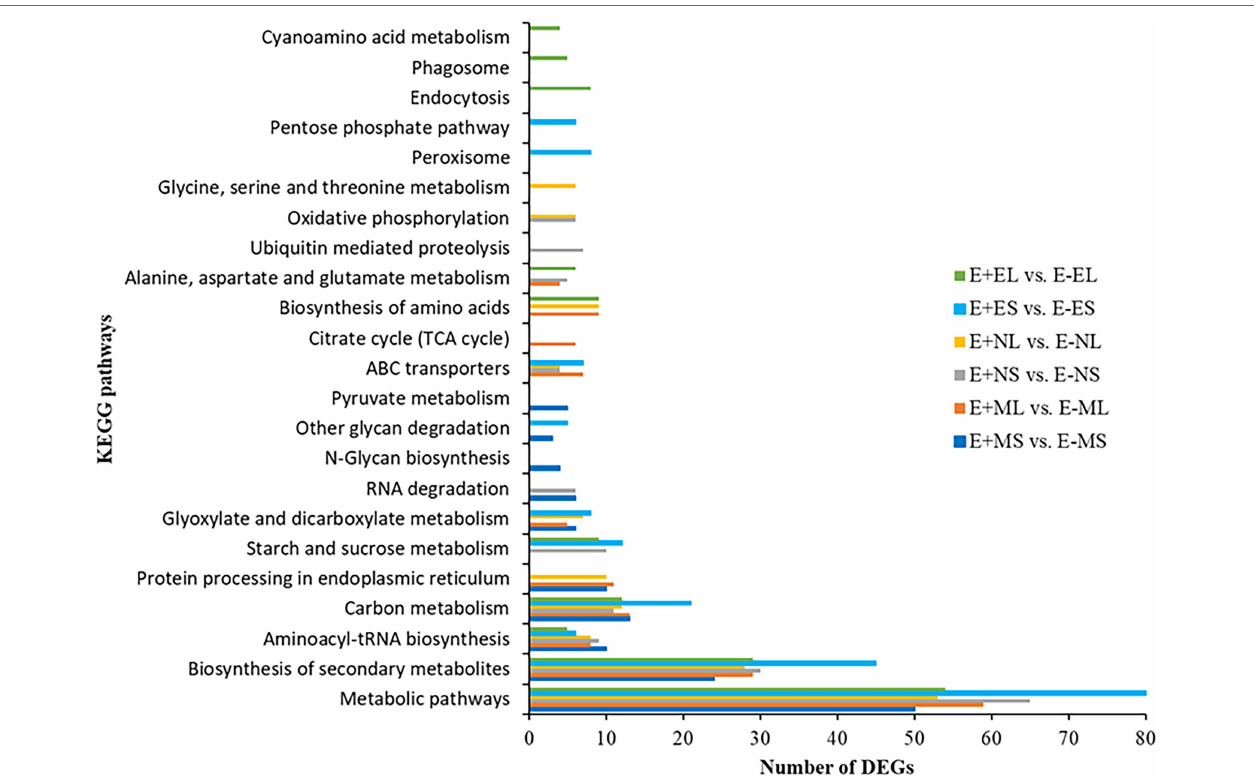
FIGURE 5 | The distribution of differentially expressed genes in KEGG pathways. The top 10 enriched KEGG pathways based on FDR-corrected value of p ( p < 0.05) in each six comparisons, E+MS vs. E − MS, E+ML vs. E − ML, E+NS vs. E − NS, E+NL vs. E − NL, E+ES vs. E − ES, and E+EL vs. E − EL were displayed in y -axis and the number of DEGs under each KEGG pathways were displayed in x -axis. Abbreviations of the samples are the same as in Figure 1